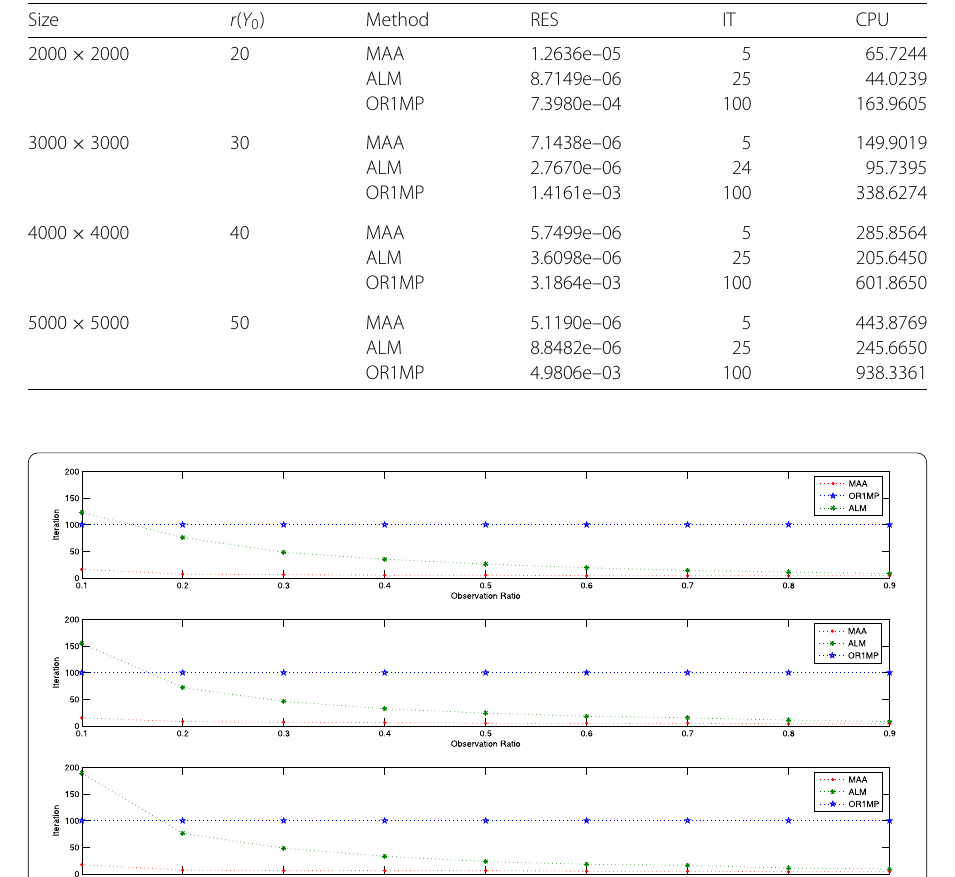
Table 4 Comparison results of three methods for p = 0.5